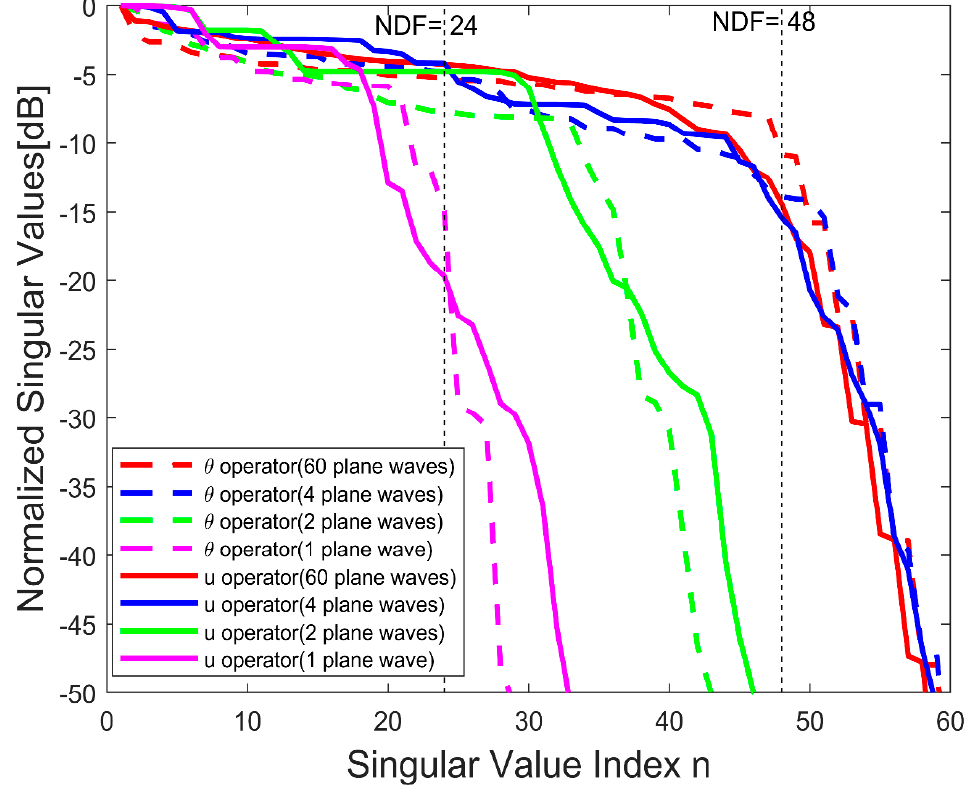
Figure 12. Normalized singular values of both (36) and the relevant operator L u for different numbers of impinging plane waves.